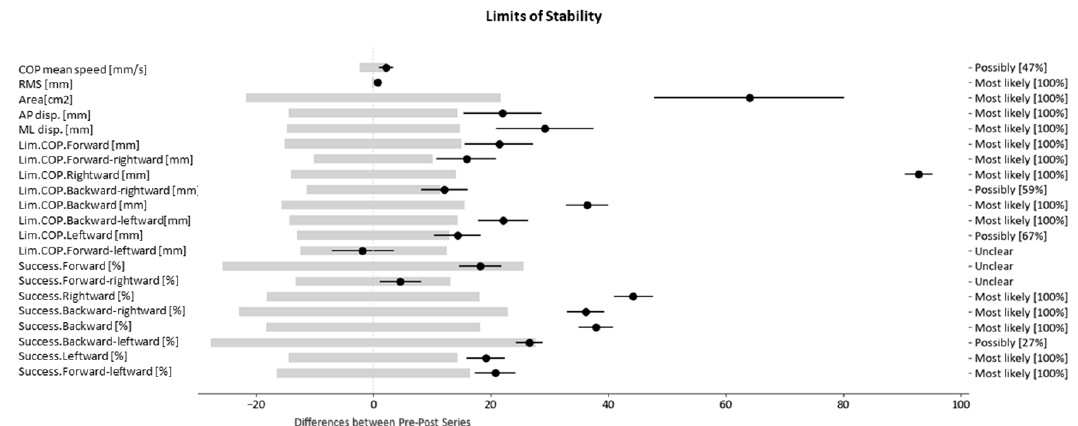
Figure 2. Patient level analysis. Romberg Test. Minimal detectable change (MDC): light grey bars; Differences: thin Black bars.